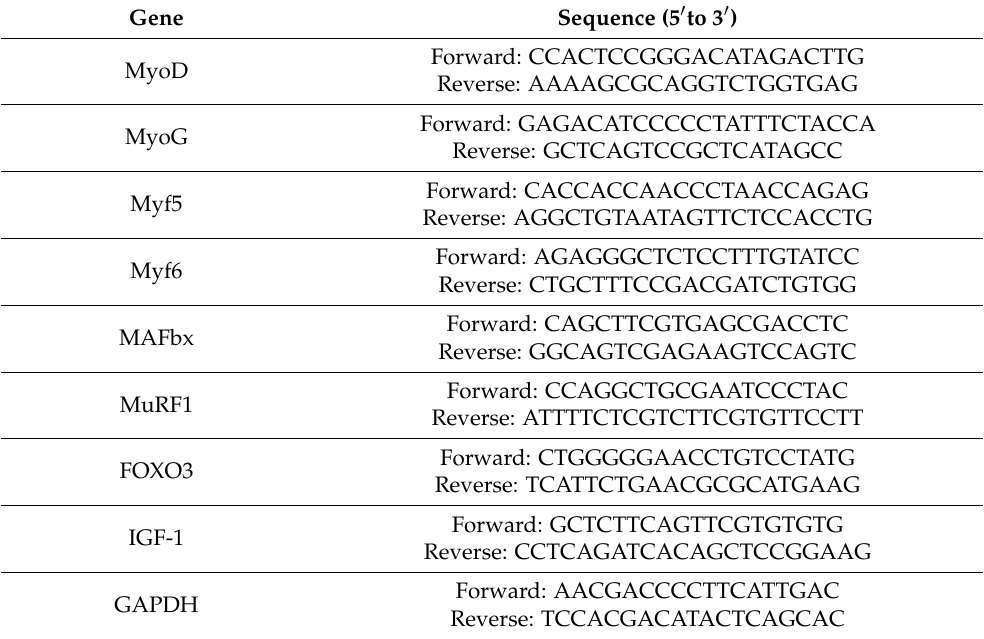
Table 1. Primer sequence for real-time